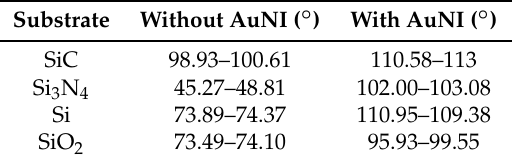
Table 2. Contact angle measurements on ceramic substrates depending on AuNI